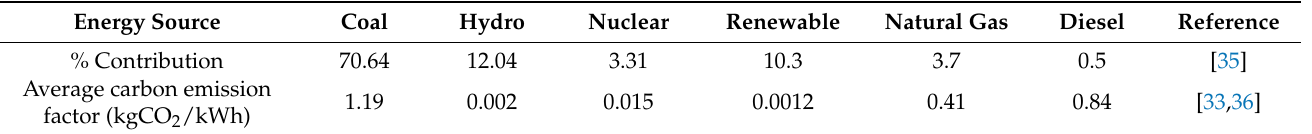
Table 4. Electricity mix in India.